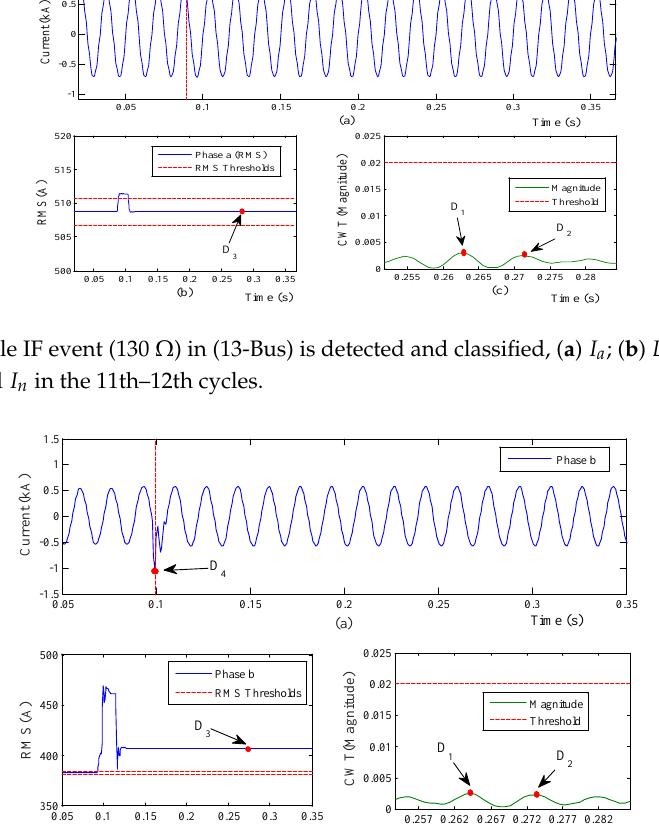
Figure 10. Self-cleared CB restrike in (13-Bus) is detected and classified, ( a ) I and D 2 of the normalized I n in the 11th–12th cycles. Energies 2018 , 11 , 546